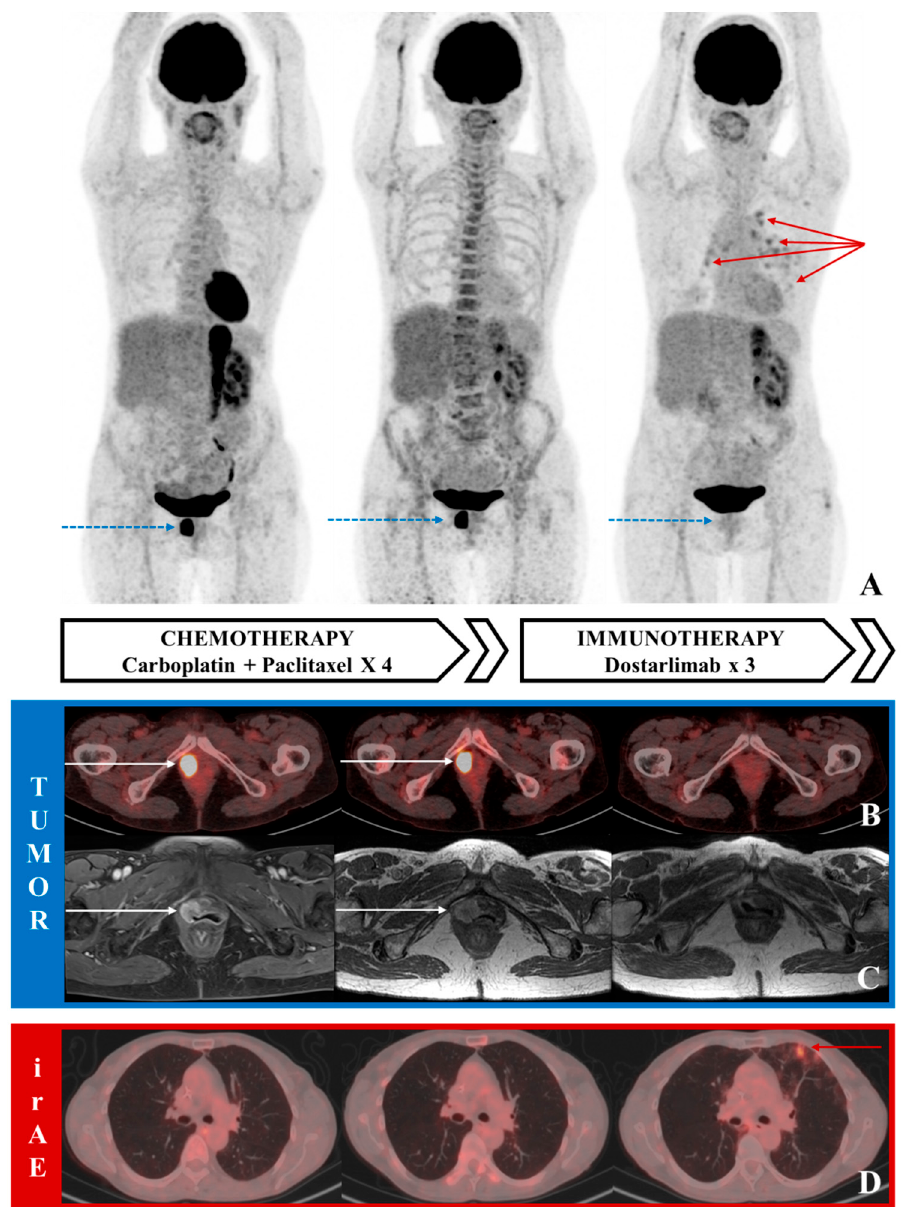
Figure 1. 18 F-FDG PET/CT images and axial T1 gadolinium-enhanced pelvic MRI (with fat-saturation for the left image and without for the two others, because fat-saturation technique was not available/performed) at recurrence and follow-up during chemotherapy and immunotherapy showing pathological FDG uptake ( A : maximum intensity projection-MIP PET images; B : fused axial PET/CT images) and contrast enhancement ( C ) corresponding to the tumor lesion in the vagina (blue arrows on the MIP, white arrows on 18 F-FDG PET/CT and MRI images), without any metabolic or morphologic changes under chemotherapy. After three injections of dostarlimab, a complete response was observed both on pelvic MRI and 18 F-FDG PET/CT, associated with irAE (immune-related adverse event) pneumonitis, suggested by hypermetabolic peripheral reticular markings (red arrows on the MIP and 18 F-FDG PET/CT images) and small ground-glass opacities ( D ), then confirmed by bronchoalveolar lavage.